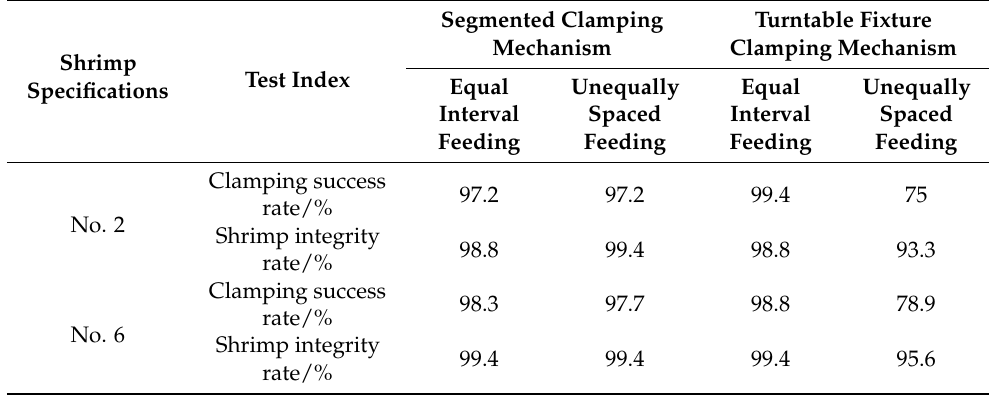
Table 1. Comparison test